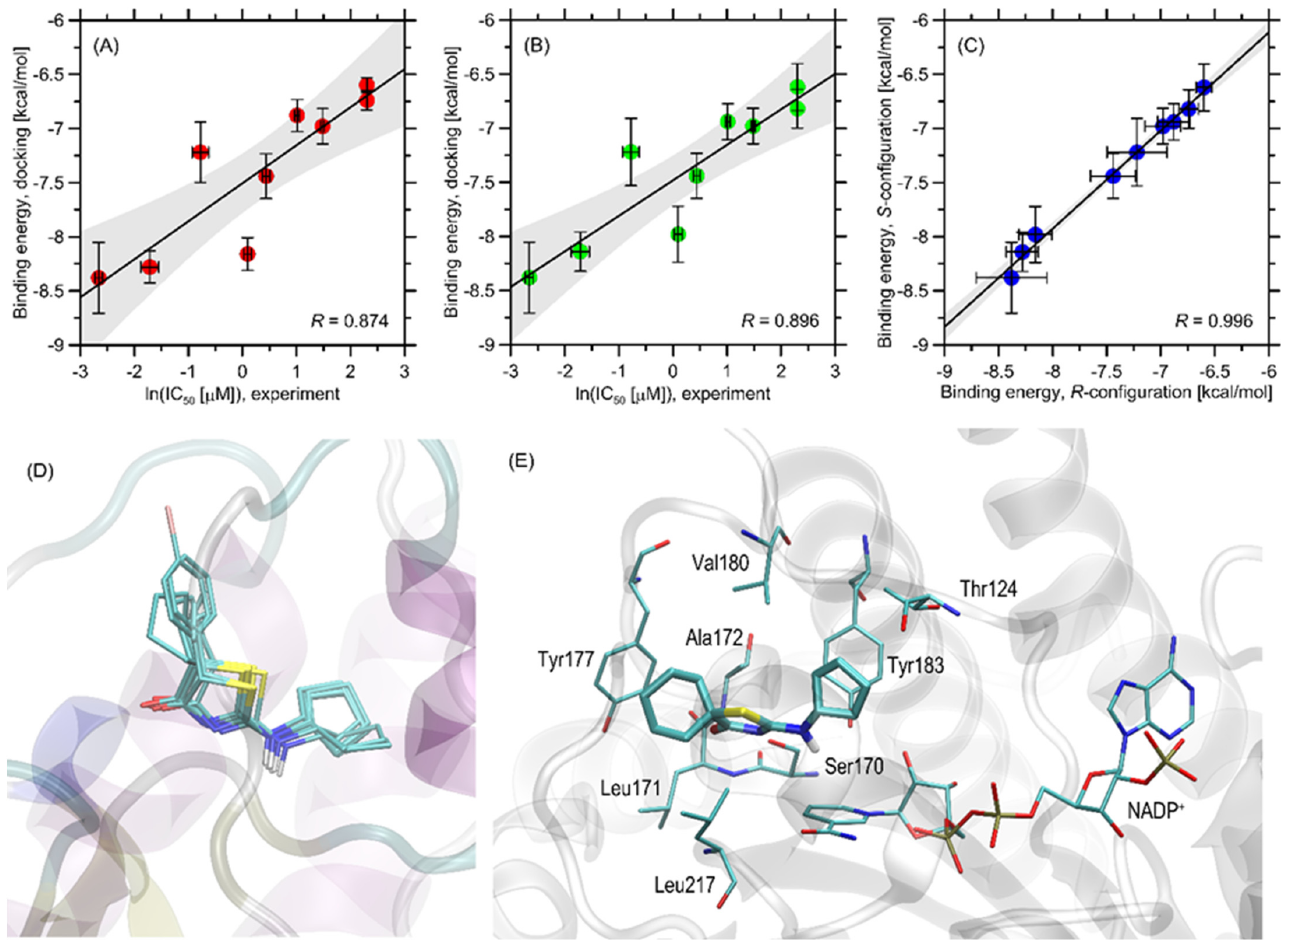
Figure 3. ( A ) The correlation between the binding energies calculated for compounds with R-configuration at the chiral center, averaged over the five protein structures used for docking and the corresponding (experimental) values of IC 50 (recalculated as log(IC 50 )). The horizontal bars represent the standard deviation values within the set of binding energies. The solid line represents the linear regression (with 95% confidence intervals filled in grey) ( B ) The same as in ( A ) but for compounds with the S-configuration. ( C ) The correlation of theoretical binding energies determined for compounds with the R- and S-configurations. ( D ) The superposed positions of all studied ligands of S-configuration (stick representation) in the binding cavity of the PDB:4bb5 structure. All these positions were identified as the optimal ones during the docking procedure. ( E ) The energetically favorable location of the 3h compound molecule bound to the PDB:4bb5 structure. The ligand molecule is shown as thick sticks, whereas all the closest amino-acid residues (<0.4 nm) are represented by thin sticks. The NADP + molecule also present in the protein crystal structure is included. The description of the interaction types is given in the